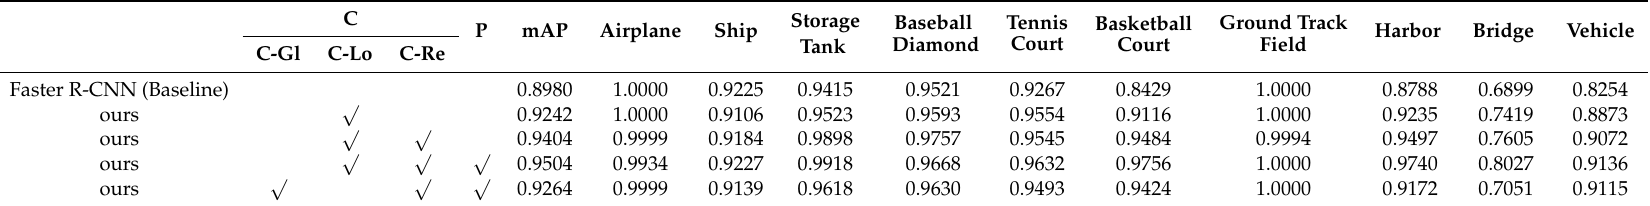
Table 1. Detection results of using sub-networks. C-Gl: Incorporate the Contextual Information Fusion Sub-network only containing global contextual information for the entire image. C-Lo: Incorporate the Contextual Information Fusion Sub-network only containing local contextual information. C-Re: Incorporate the Contextual Information Fusion Sub-network only containing object-object relationship contextual information. P: Incorporate the Part-based Multi-region Fusion Sub-network.